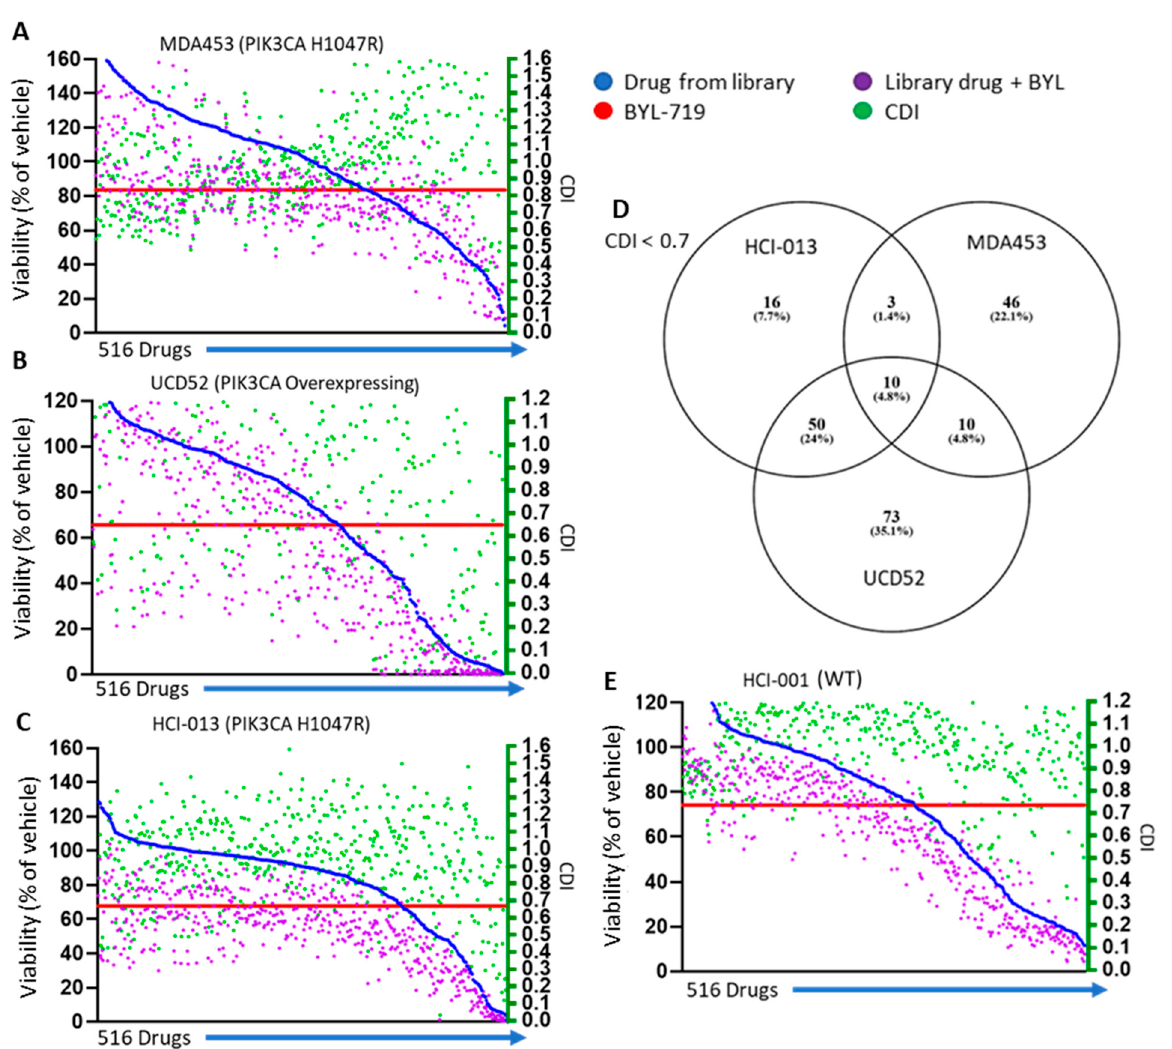
Figure 6. High throughput synergism screening revealed drug combinations of interest. A library of 516 drugs with and without BYL-719 with the viability of each drug (left x -axis) and CDI (right x -axis) for each drug combination in ( A – C ) PIK3CA pathogenic models and ( D ) Venn diagrams of drugs under 0.7 CDI for oncogenic PIK3CA containing models. ( E ) Viability of single and combinatorial agents and CDI in the PIK3CA WT containing HCI-001.